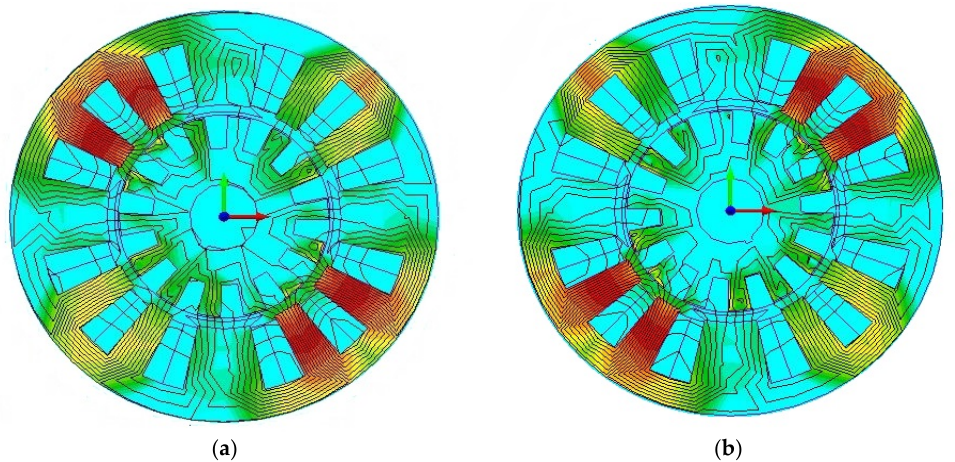
Figure 3. ( a ). Torque-winding short flux patterns under Phase A. ( b ). Torque-winding short flux patterns under Phase B.